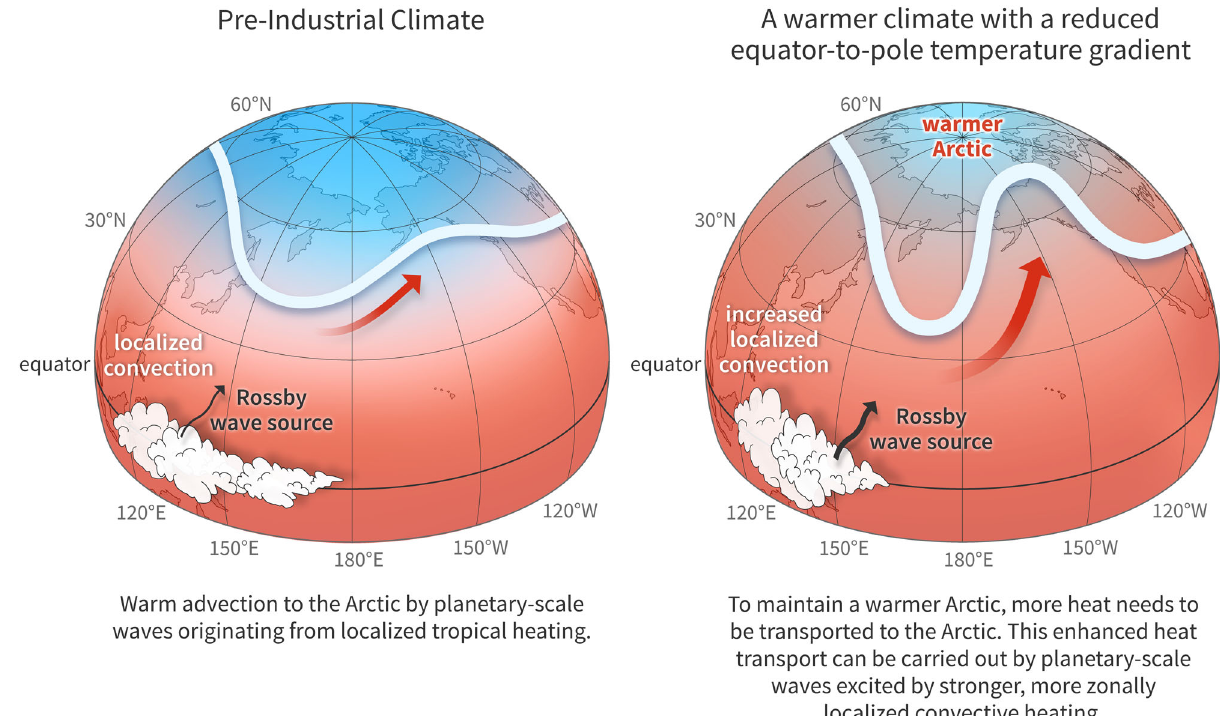
Fig. 6 Mechanism favoring a La Niña-like condition from a general circulation perspective. Left: On average, the strongest convection/ rainfall occurs over Indonesia/Maritime Continent. The divergent circulation, resulting from the convection, advects absolute vorticity poleward. This leads to the generation of planetary-scale Rossby waves in the subtropics 200 that can propagate poleward and then upward once they reach mid- and high-latitudes. As these waves propagate upward, they transport heat poleward, which warms the Arctic. Right : Paleo-climate data suggests that when the global climate was warmer than today ’ s climate, the Arctic was considerably warmer while the tropics were about the same temperature as today ’ s climate. The higher Arctic temperature implies that longwave cooling to space must have been greater as well. To maintain the warmth against the increased longwave cooling, more heat needs to be transported from lower latitudes. Amongst the various atmospheric processes, the most probable candidate that can generate a stronger poleward heat transport in the face of a weakened meridional temperature gradient is a more enhanced tropical heating/convection around the Maritime continent, which is suggestive of a more La Niña-like pattern in convective heating and SST.Credit: